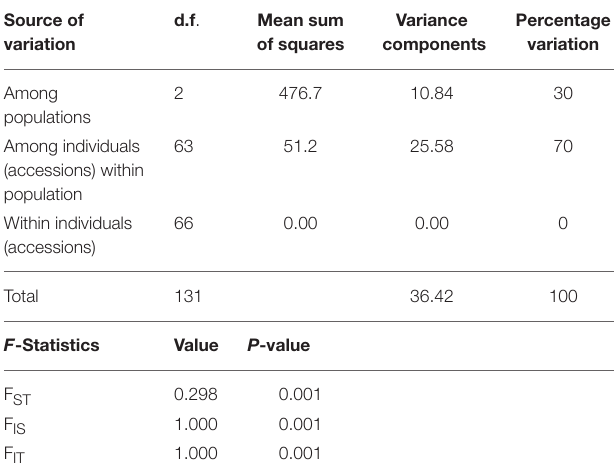
TABLE 5 | Analysis of molecular variance (AMOVA) for the three sub-populations of panel population for seedling stage cold tolerance in rice containing 66